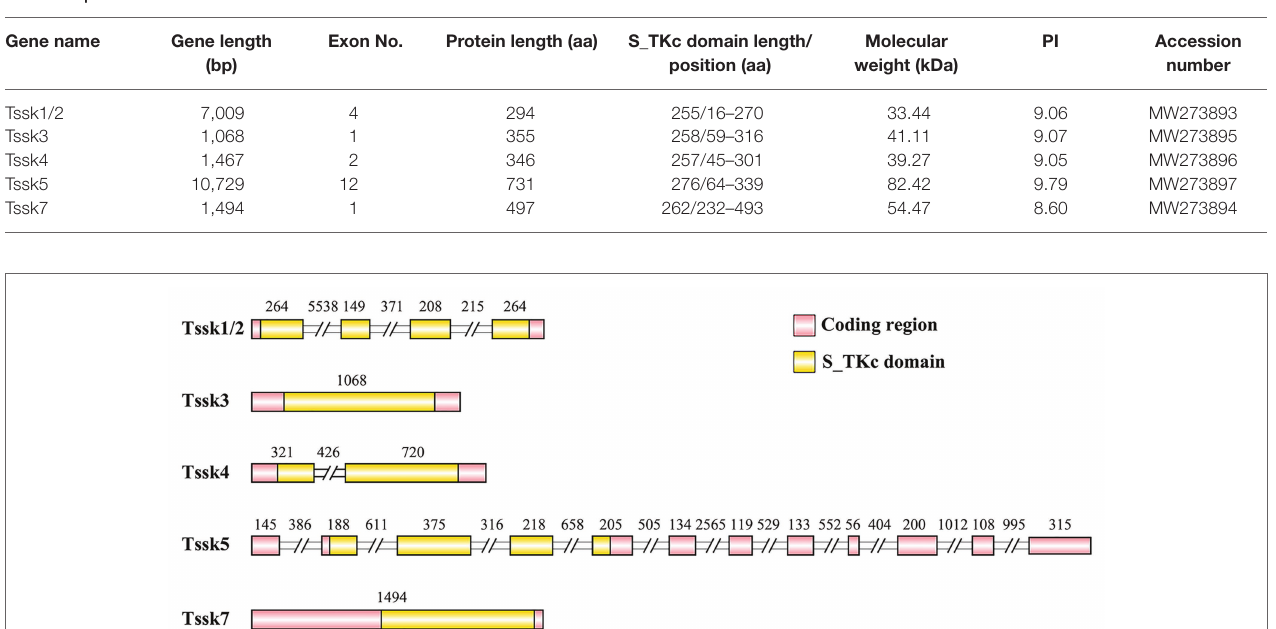
TABLE 3 | Structural characteristics of the five Tssks of A. irradians .